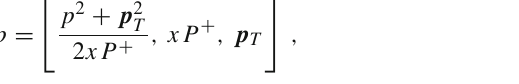
Fig. 1 Tree-level cut diagram for the calculation of T -even leading- twist gluon densities. The double dashed line represents the spin- 1 spectator. The red blob represents the nucleon-gluon-spectator vertex. Gluon lines with crosses correspond to specific Feynman rules for the gluon field tensor (see